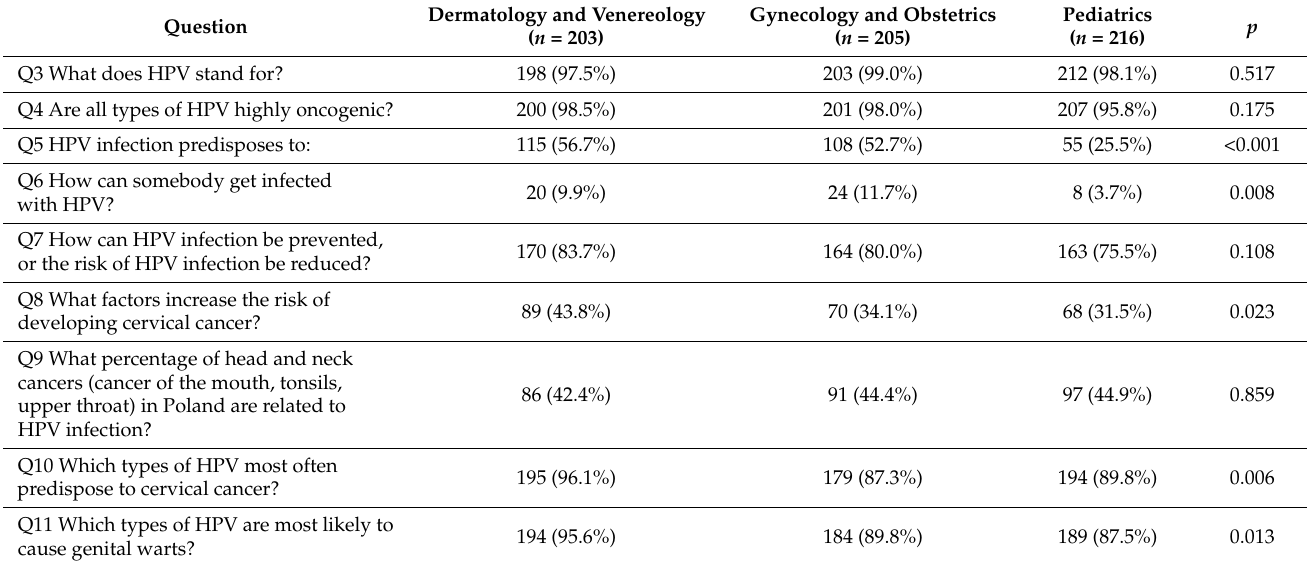
Table 5. Correct answers to the questions about HPV depending on the specialization.